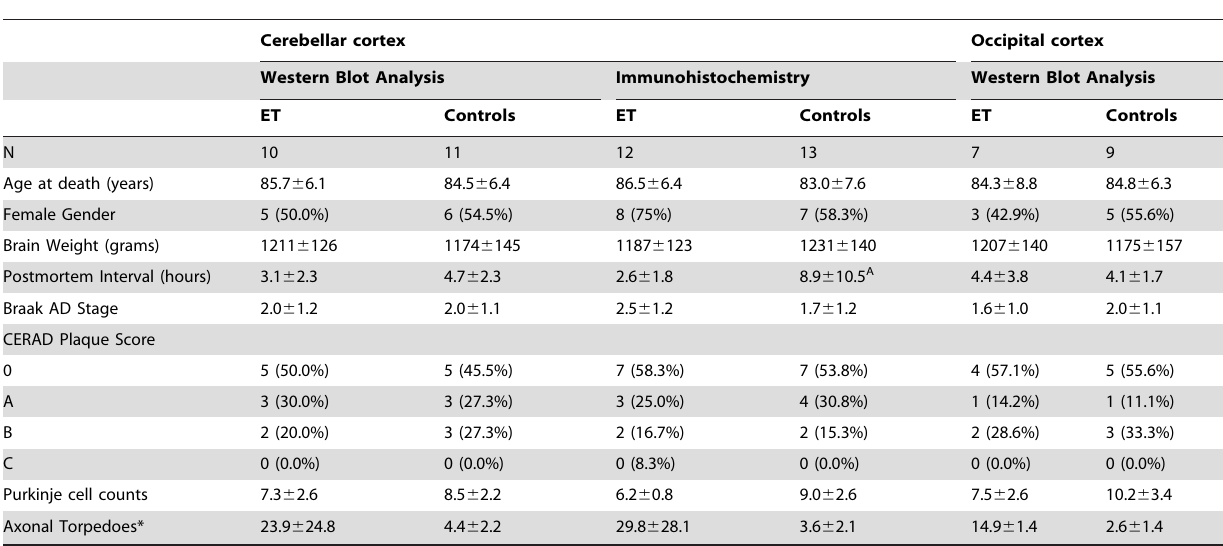
Table 1. Clinical and pathological features of ET cases and